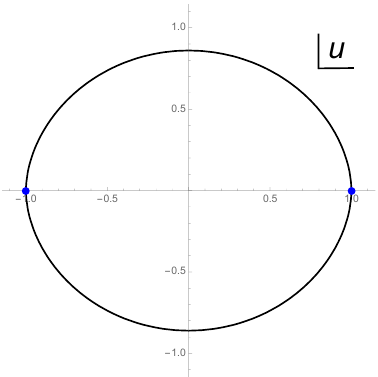
Figure 6. The unique wall of marginal stability in SU(2) gauge theory. The monopole point at u = 1 and the dyon point at u = 1 are indicated as blue −